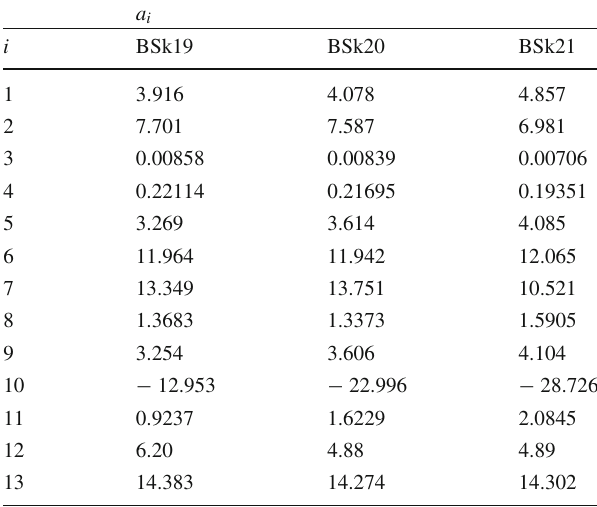
Table 2 a i parameters for BSk family of EOSs